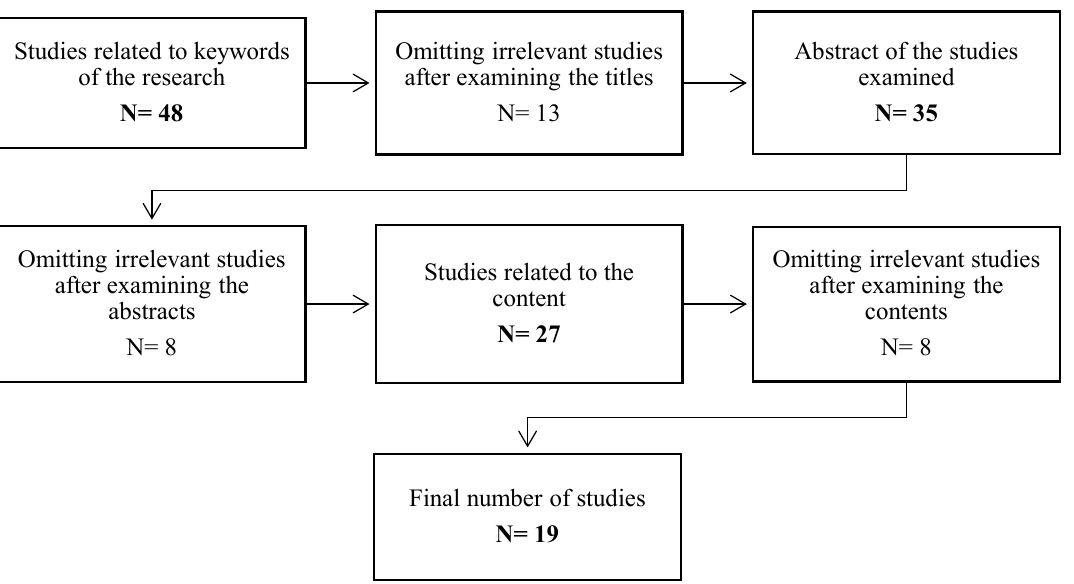
Figure 2. Stages of selecting, refining, and organizing research. Figures in bold are the number of studies remaining after completion of each step, showing how the total number of studies was